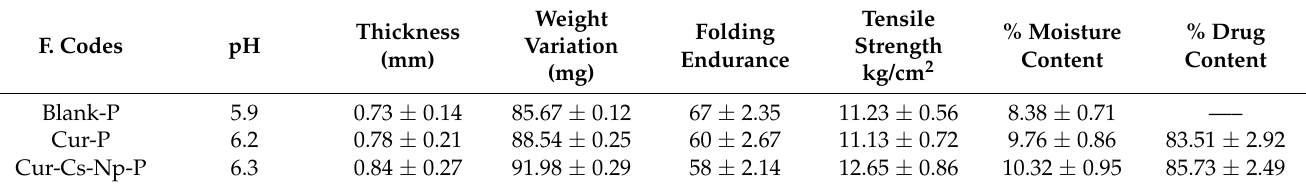
Table 2. Physicochemical characterization of prepared patches.